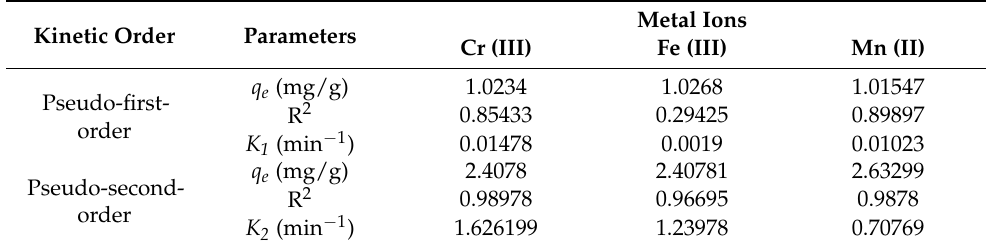
Table 3. Constants of the pseudo-first-order and pseudo-second-order